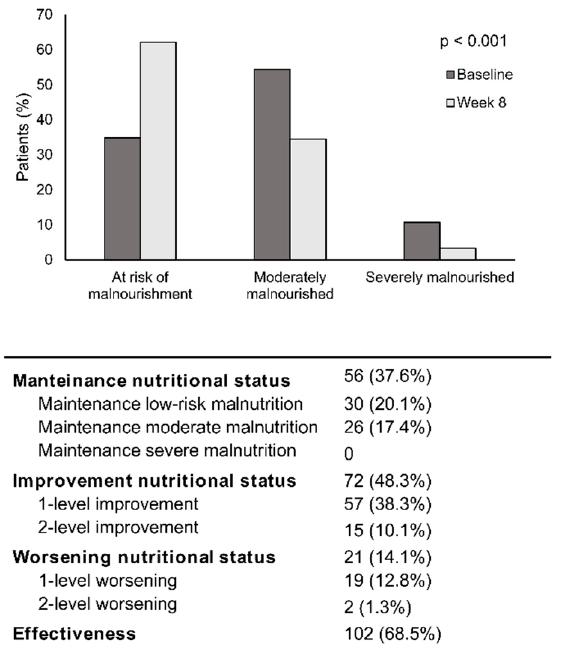
Figure 1. Change in nutritional status after 8 weeks of oligomeric enteral nutrition (OEN). The bars show the proportion of patients at risk of malnourishment and with moderate or severe malnourishment at baseline and after 8 weeks of OEN treatment. The change in the nutritional status from baseline to week 8 was statistically significant ( p < 0.001). The table shows the changes in the nutritional status (improvement and worsening) and the effectiveness of the OEN algorithm in improving the nutritional status. Patient’s nutritional status was classified as: (1) at risk of malnourishment, (2) moderate malnourishment, or (3) severe malnourishment.